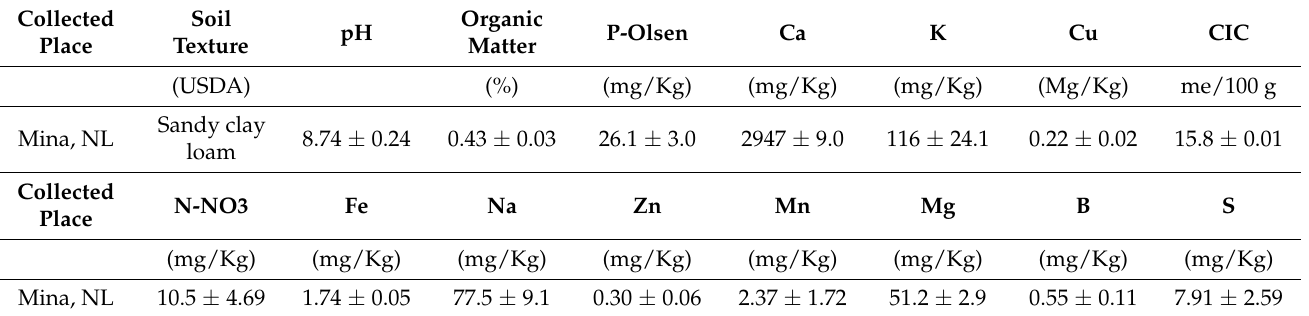
Table 1. The abundance of macronutrients and micronutrients in the physical–chemical analysis in the soil of Mina, Nuevo